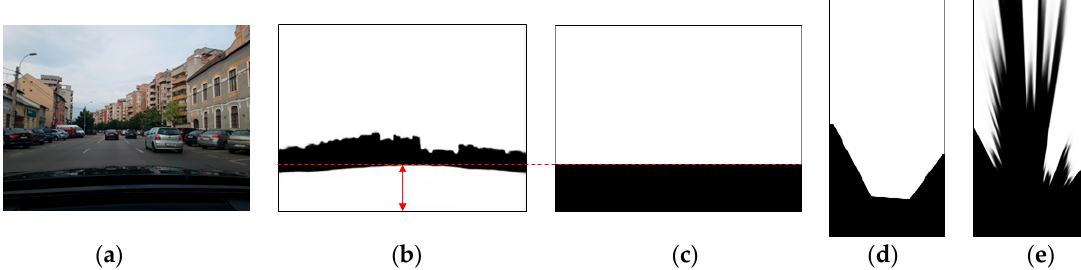
Figure 4. Transforming the perspective color image into usable measurement: ( a ) Perspective color image; ( b ) segmented image, highlighting the obstacle areas (white) and the free area (black); ( c ) useful area mask; ( d ) grid visibility mask; ( e ) bird’s-eye view of the segmented image.